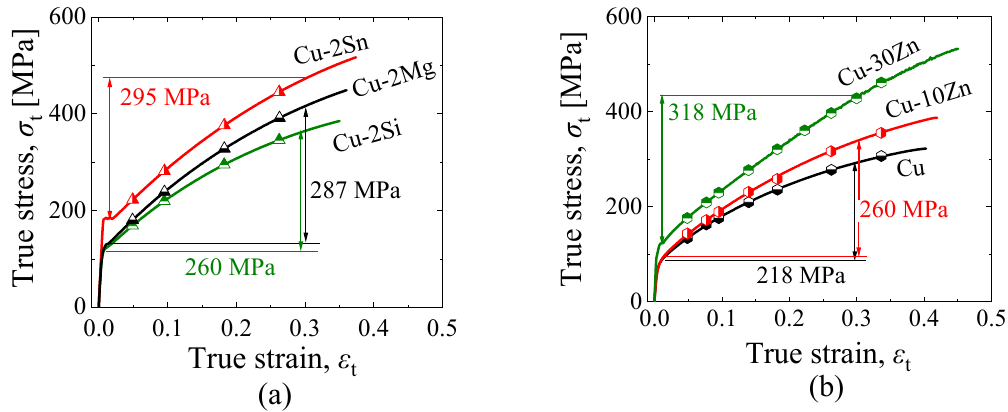
Figure 14. True stress–strain curves for: ( a ) Cu-2Mg, Cu-2Sn, and Cu-2Si [1]; ( b ) Cu, Cu-10Zn, and Cu-30Zn [2]. Specimens were deformed at the strains denoted by curve marks to conduct XRD measurements.